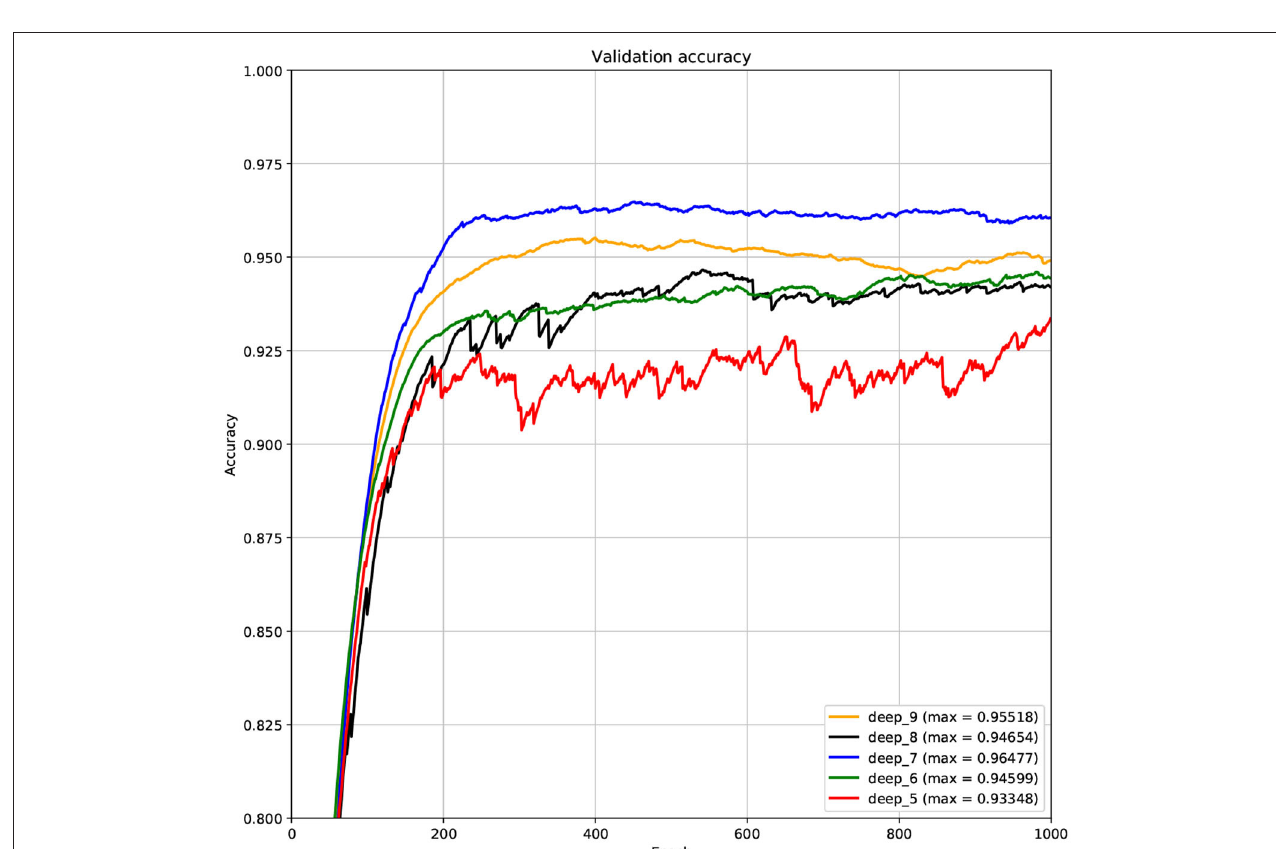
FIGURE 4 | The variation curve of the validation